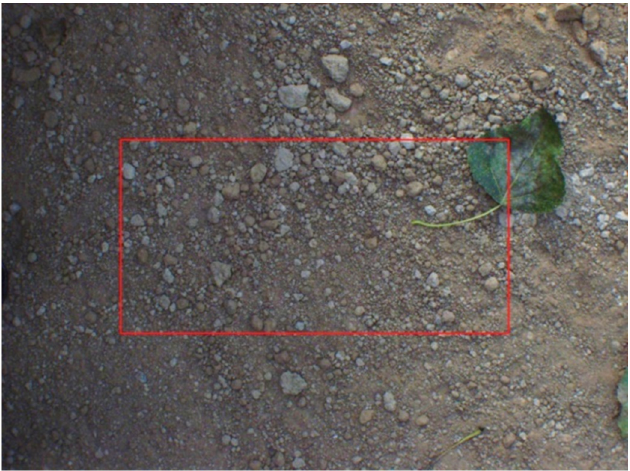
Figure 1. The calculation process of the wheel forward displacement.